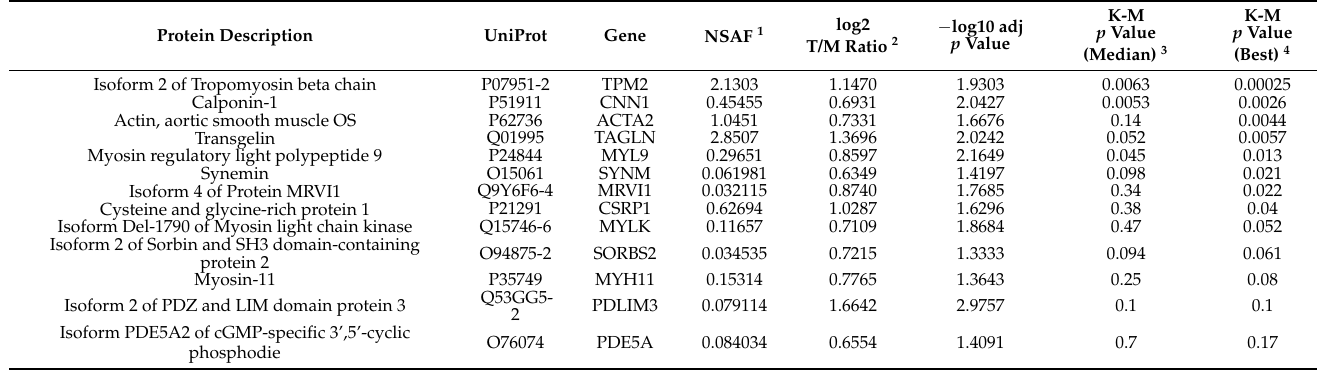
Table 1. Most abundant stromal-lineage-associated proteins upregulated in TASCs versus MASCs. Protein